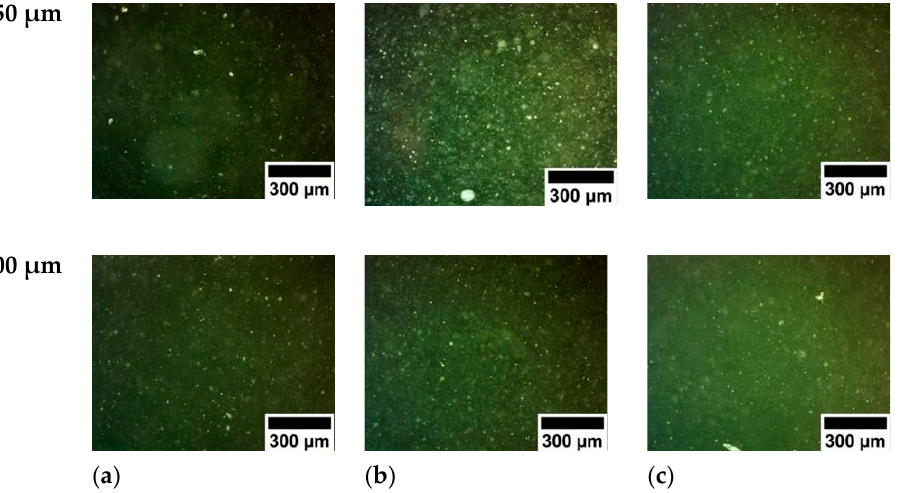
Figure 2. Optical microscopy images of PDMS-YbEr membranes with thicknesses of 150 μ m ( upper row ) and 300 μ m ( lower row ) and phosphor concentration of ( a ) 1.5%, ( b ) 2.0 and ( c ) 2.5%.